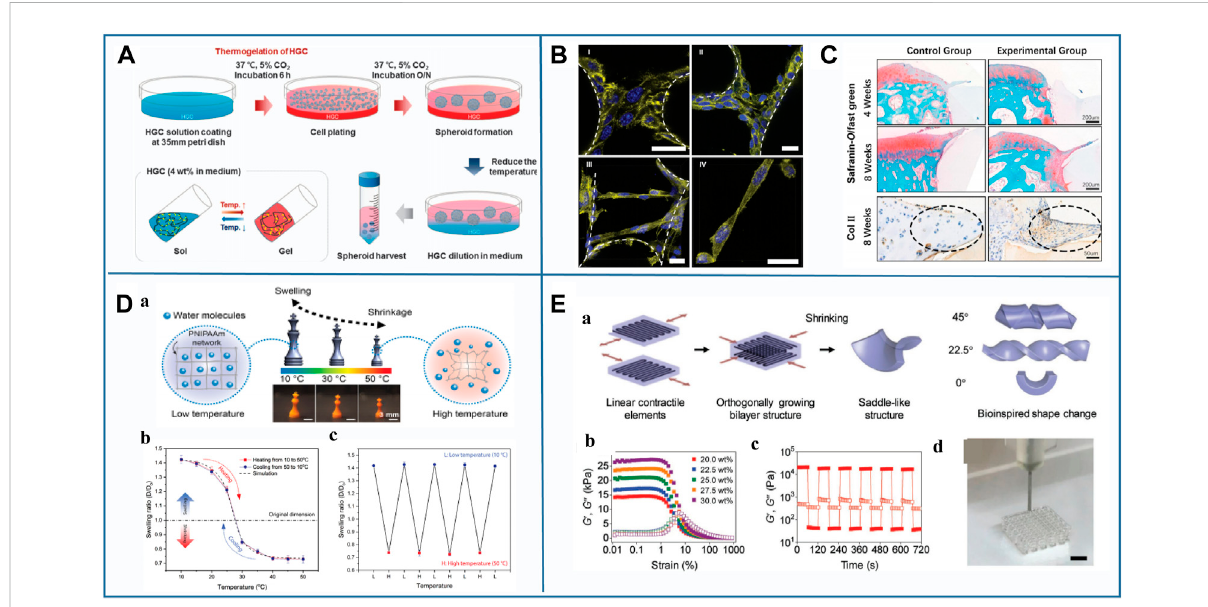
FIGURE 8 Representativestudiesofthermosensitivenanomaterialsincellcultureand3Dprinting. (A) Schematicillustrationofcoatingthesurfaceofacell cultureplateusingHGCandtheprocessofspheroidformationonanHGC-coatedplate.ReprintedwithpermissionfromChoetal.(2016).Copyright © 2016NPGAsiaMaterials. (B) 3D fi broblastgrowthinsideinterlinkedmacroporousmicrogelscaffolds.ReprintedwithpermissionfromRommeletal. (2022). Copyright © 2022 Advance Science. (C) Histological analysis of cartilage regeneration. Reprinted with permission from Guo J. et al (2022). Copyright © 2022 American Chemical Society. (D) Temperature responsive swelling of 3D printed PNIPAAm hydrogel structure (b) and (c) reversible temperature-dependent swelling/shrinkage of PNIPAAm hydrogel. Reprinted with permission from Han et al. (2018). Copyright © 2018 Scienti fi c Reports. (E) Characterization of 3D printing of orthogonally growing bilayer structures of hydrogels with programmed motions. Reprinted with permissio from Arslan et al. (2019) Copyright © 2018 Advance